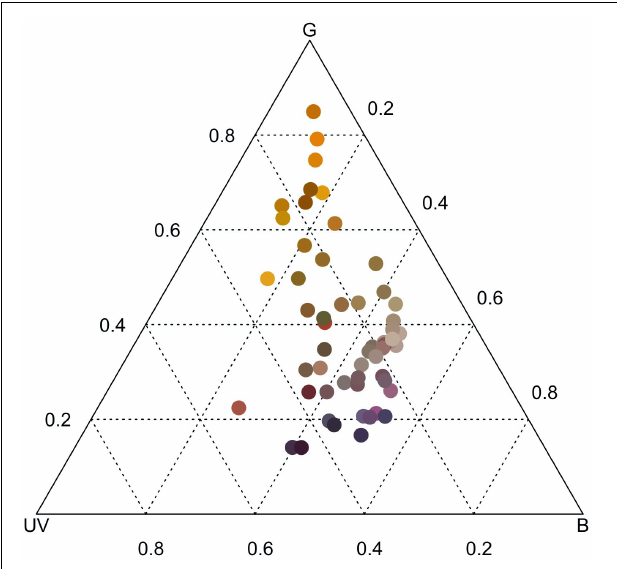
FIGURE 2 | Bee color space depicting the differential stimulation of color photoreceptor types of Apis mellifera with all 55 co-flowering species from serpentine seep community. Color of circles represents human-perceived color of flowering structure for each